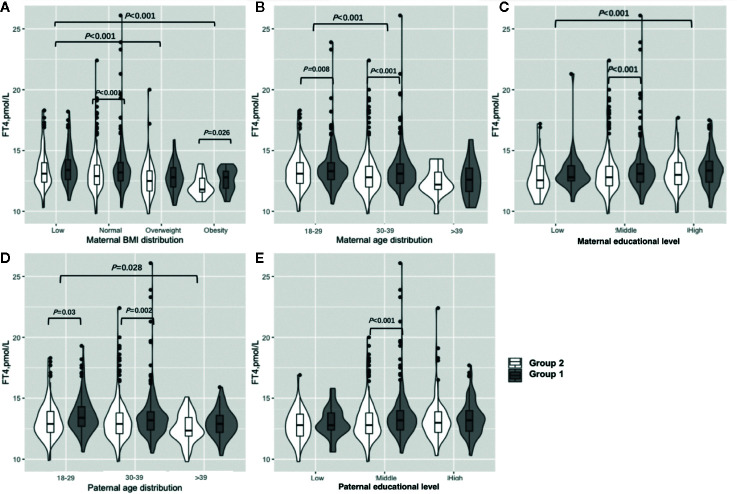
Subgroup analysis of FT4 concentration in the Propensity-Score-Matched Cohort. Figure shows the FT4 concentration in different subgroup of Group 1 and Group 2. The violin diagram is a combination of box plot and density plot. The thick black bar in the middle of the boxplot represents the median and quartile range, and the black line extending up and down represents the 95% confidence interval. The black dots on the black line indicate data values that exceed the 95% confidence interval. The outer contour indicates the distribution of the data. (A) Maternal BMI distribution. (B) Maternal age distribution. (C) Maternal educational level. (D) Paternal age distribution. (E) Paternal educational level.